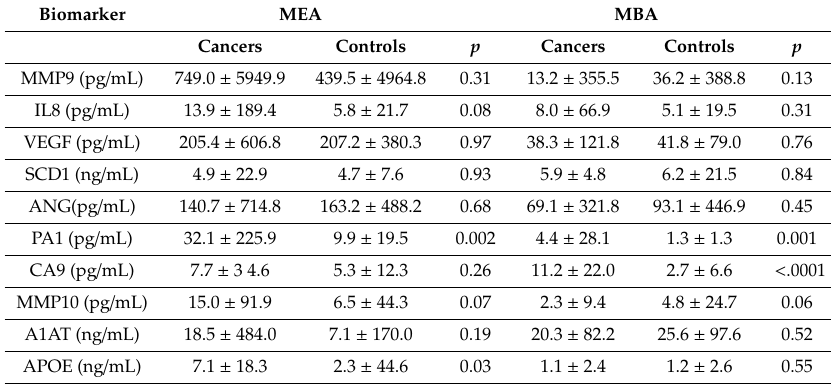
Table 3. Geometric mean ( ± SD) urinary concentrations of biomarkers assessed by MEA and MBA. Biomarker